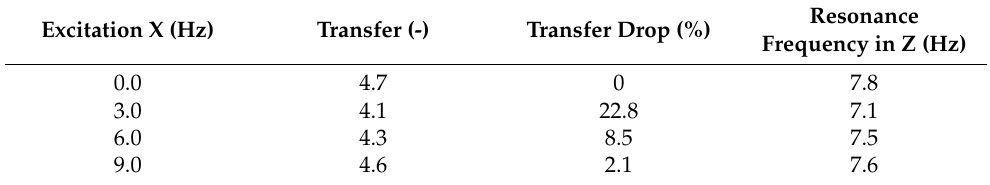
Figure 12. Transfer for Z-axis excitation 3 to 10 Hz and excitation in X-axis 3, 6, 9 Hz. Table 1 summarizes the values of amplitudes and frequencies of resonance in the Z axis depending on the frequency of horizontal excitation. The results show that there are two effects if we introduce excitation in the X axis. The first effect is that the natural frequency is reduced. The second effect is that the transfer value is reduced. A more pronounced drop higher excitation frequencies, the drop was smaller, 2.1% for 9 Hz. Table 1. Transfer drop and resonance frequency for Z-axis at excitation in Z-axis from 3 to 10 Hz and excitation in X-axis.